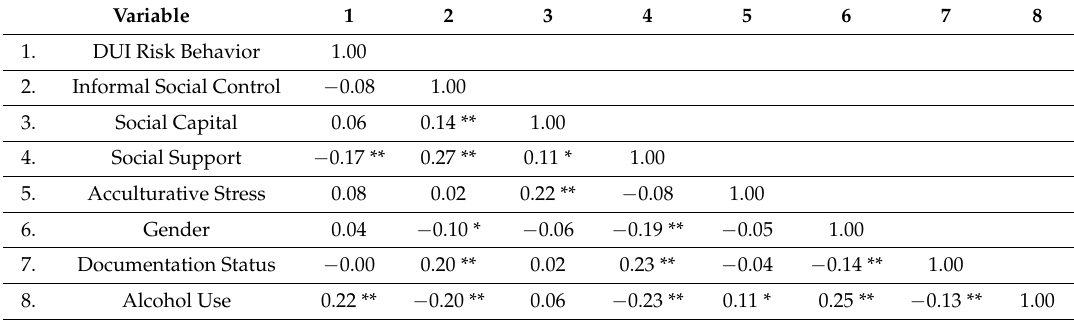
Table 2. Bivariate correlations of key observed